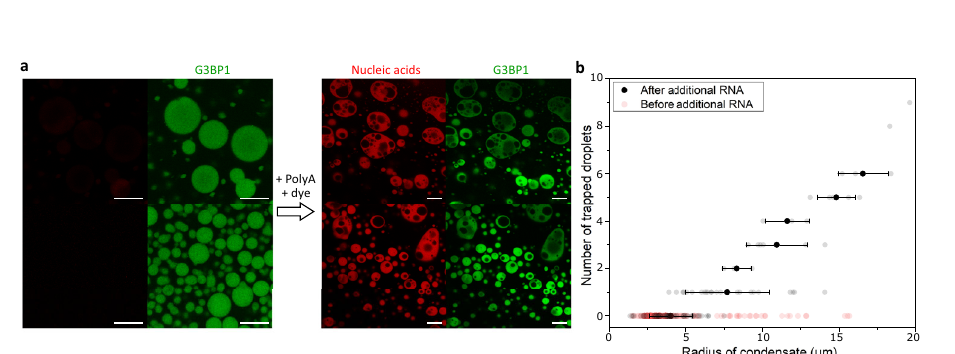
Fig. 3 | Dynamics of trapped droplets and merging events. a Trapped droplets inside of Poly-rA PEG condensates can merge with each other and with the outer dilute phase. The sample was incubated at 35°C. Poly-rA is shown, the scale bar shows10 μ m. b The number and c averageradius ofthe trapped droplets isshown over time, which follows the expected scaling laws (Supplementary Note 1). From